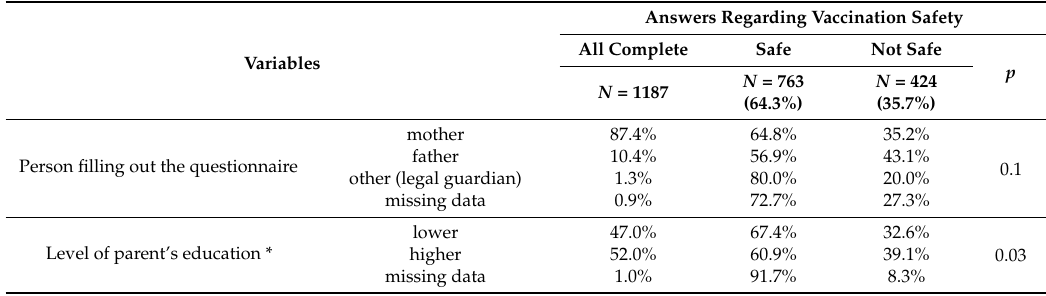
Table 2. Opinion about safety of children’s vaccinations according to selected variables, with statistical significance of differences (only complete